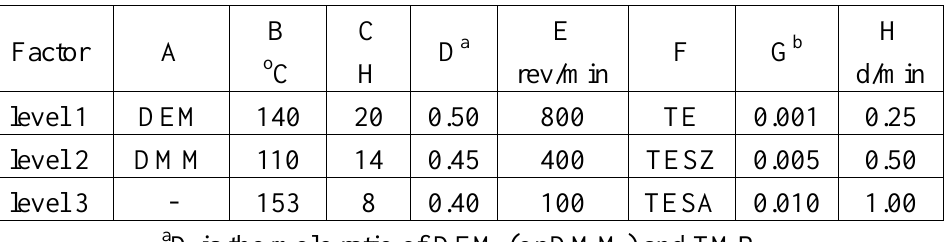
Table 1. The factor levels for the synthesis of